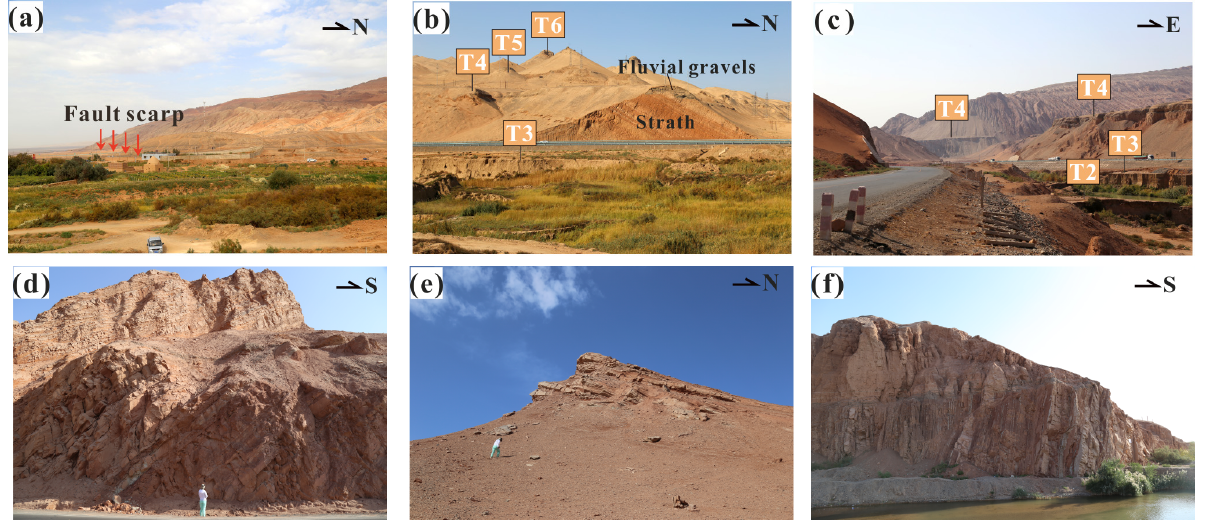
Figure 6. ( a ) Red arrows show the location of the fault scarp. ( b , c ) Views N and E of the river terraces across the Shengjingou Valley (T1–T6, from young to old). ( d – f ) Views S, N, and S of the bedrock outcrop in the Shengjingou Valley (locations in Figure 5a).